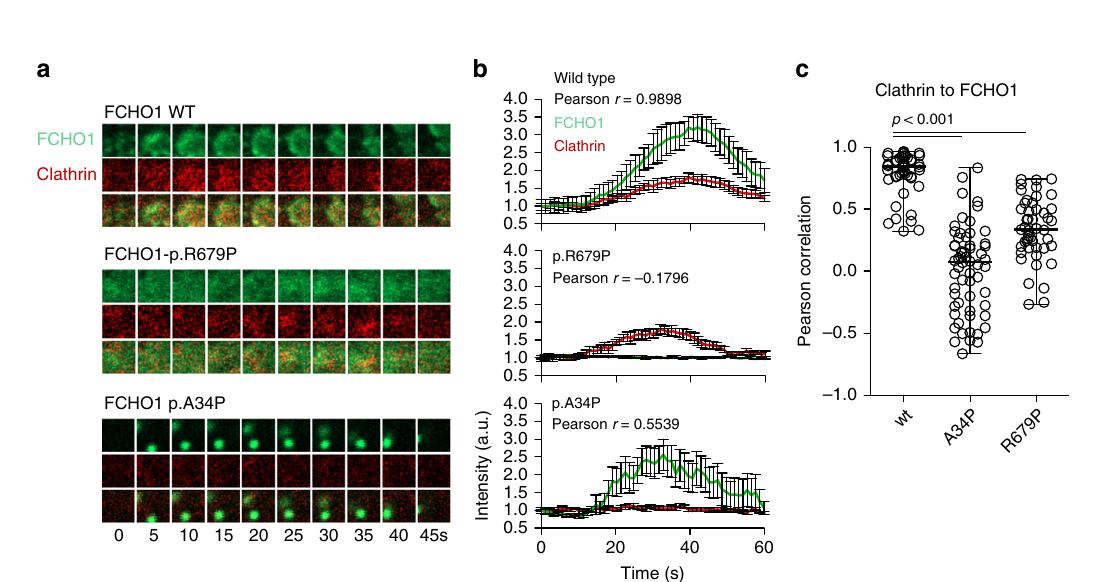
Fig. 3 Mutations in both µ HD and F-BAR domains of FCHO1 prevent nucleation of clathrin-coated pits (CCP). a The dynamics of FCHO1-medicated nucleation of CCP in FCHO1-de fi cient SK-MEL-2 cells expressing RFP-tagged clathrin light chain from endogenous locus (CLTA RFP/wt ) transduced with either wild-type (upper panel), µ HD-mutated (p.R679 – middle panel) or F-BAR-mutated (p.A34P – bottom panel) GFP-FCHO1 fusion protein. Two micrometre-wide sections of representative movies are shown. Full movies are available in supplemental materials. In the middle panel, contrast was reduced and brightness was increased as to show a diffused signal of GFP at the plasma membrane. b Time dependence of the fl uorescent intensity of FCHO1 (green) and endogenous clathrin (red) averaged from nine independent movies. Only the fl uorescence of wild-type but not mutant FCHO1 correlates with clathrin. Each channel was normalised to the background and the initial fl uorescence was set to 1. Error bars represent SEM of mean fl uorescence intensity, n = 9 biologically independent cells from minimum three independent experiments. c Pearson correlation of FCHO1 and clathrin from individual movies. Pooled data from three independent experiments. Each symbol represents one square region of 25 µ m 2 . Up to three regions per cells were quanti fi ed. Horizontal lines indicate the median. Statistical analysis of signi fi cance was performed using one-way ANOVA test followed by Tukey ’ s multiple comparison test to assess differences between groups Source data are provided as a Source Data fi